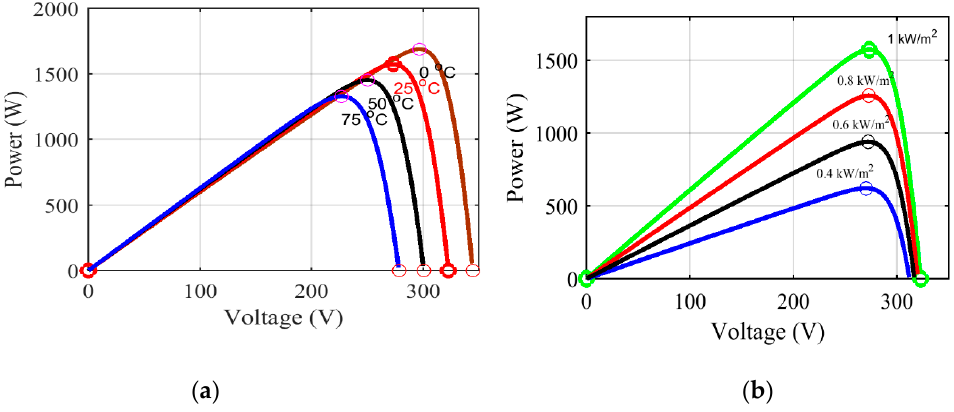
Figure 1. P-V characteristics curve of a PV solar cell ( a ) Temperature ( b ) Irradiance